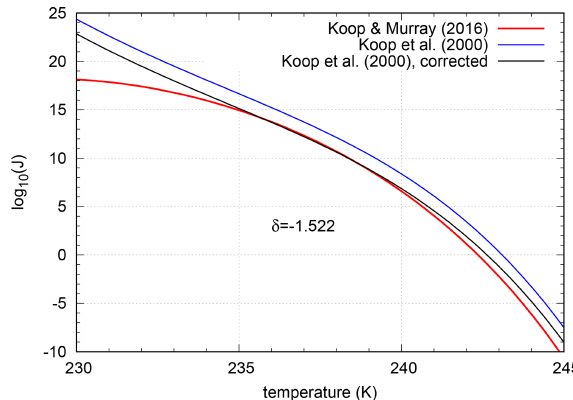
Figure 1. Nucleation rates for pure super-cooled water droplets (Koop and Murray, 2016, red) and aqueous solution droplets (Koop et al., 2000) at water saturation (i.e. infinitely dissolved); original values by Koop et al. (2000) in blue and shifted values ( δ = − 1 . 522) in black (new reference nucleation rate J sol , new ). For the calcula- tion, the saturation vapour pressure formulae by Murphy and Koop (2005) are